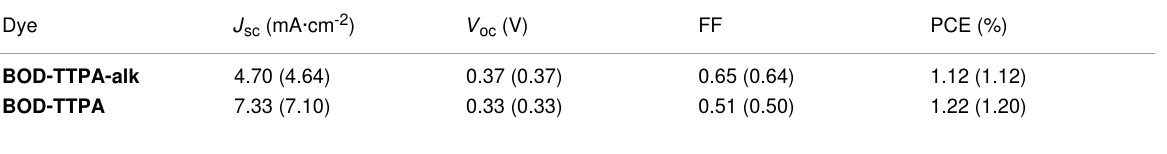
Table 2: Photovoltaic parameters of compounds BOD-TTPA-alk and BOD-TTPA (light source: AM1.5G at 100 mW·cm − 2 , electrolyte composition: 0.5 M of BMII, 0.03 M of I 2 , 0.5 M of LiI, 0.1 M of guanidinium thiocyanate in a mixture of acetonitrile and 3-methoxyproprionitrile (85:15, v/v), elec-